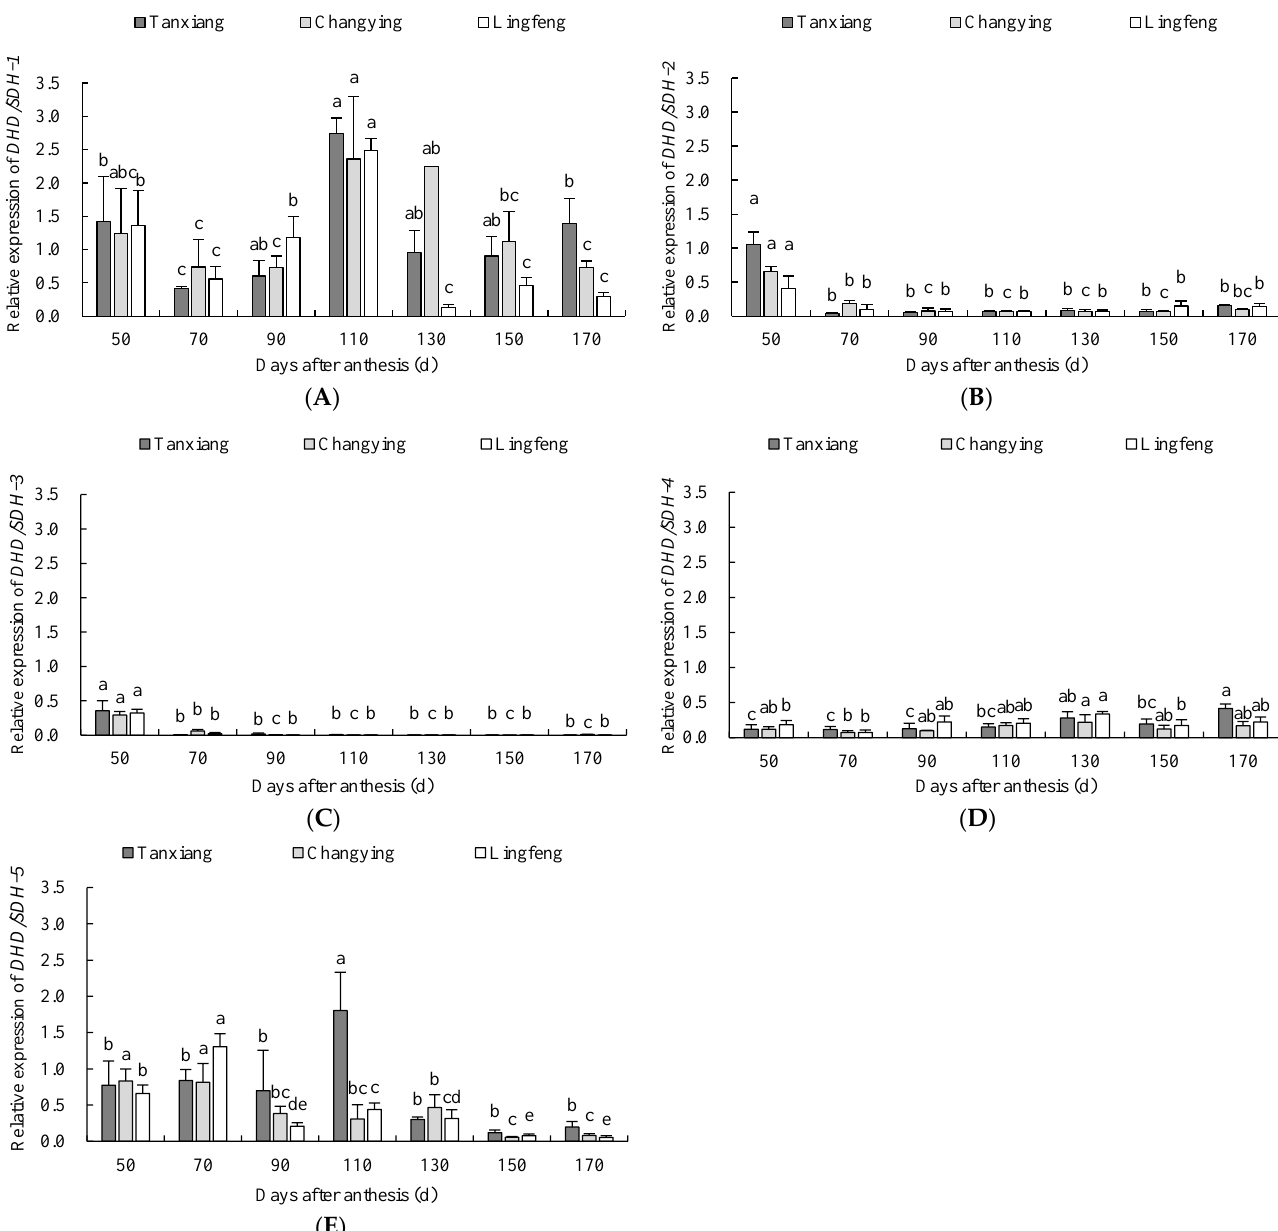
Figure 5. Expression of DHD/SDHs in Chinese olive fruit at different developmental stages. Bars represent the standard deviation for three biological replicates. Different letters indicate significant differences among different stages of the same cultivars ( p < 0.05). ( A ) DHD/SDH-1 , ( B ) DHD/SDH-2 , ( C ) DHD/SDH-3 , ( D ) DHD/SDH-4 and ( E ) DHD/SDH-5 .